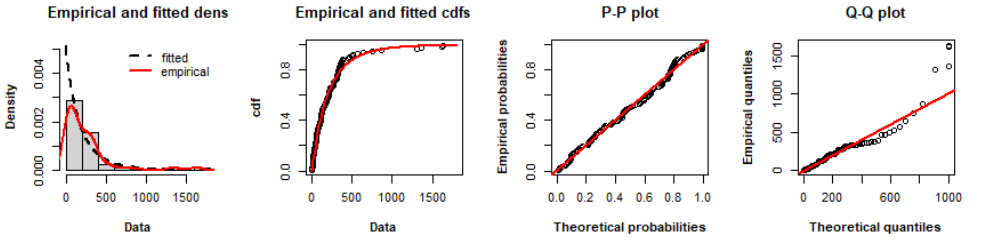
Figure 8. Empirical density, empirical cdf, P-P plot and Q-Q plot of the fitted MPoE distribution to coal-mining